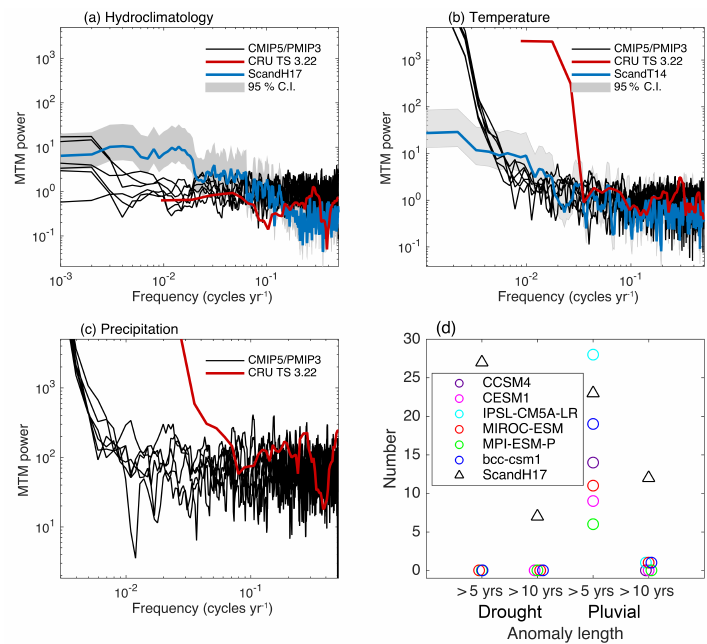
Figure 3. Spectral properties (multi-taper approach, four tapers) of (a) SPEI, (b) temperature, and (c) precipitation over the common 1100– 1995 period. For SPEI and temperature, the spectral properties of individual GCMs (r1i1p1 ensemble) are compared to those of the tree-ring ScandH17 and ScandT14 reconstructions and regionally averaged instrumental CRU TS 3.22 data. Shaded areas show the 95% confidence interval of the reconstruction spectra. (d) The number of droughts and pluvials in the reconstructed and simulated time series that are > 5 and > 10 years in duration. Spectral properties of the individual models are provided in Fig.